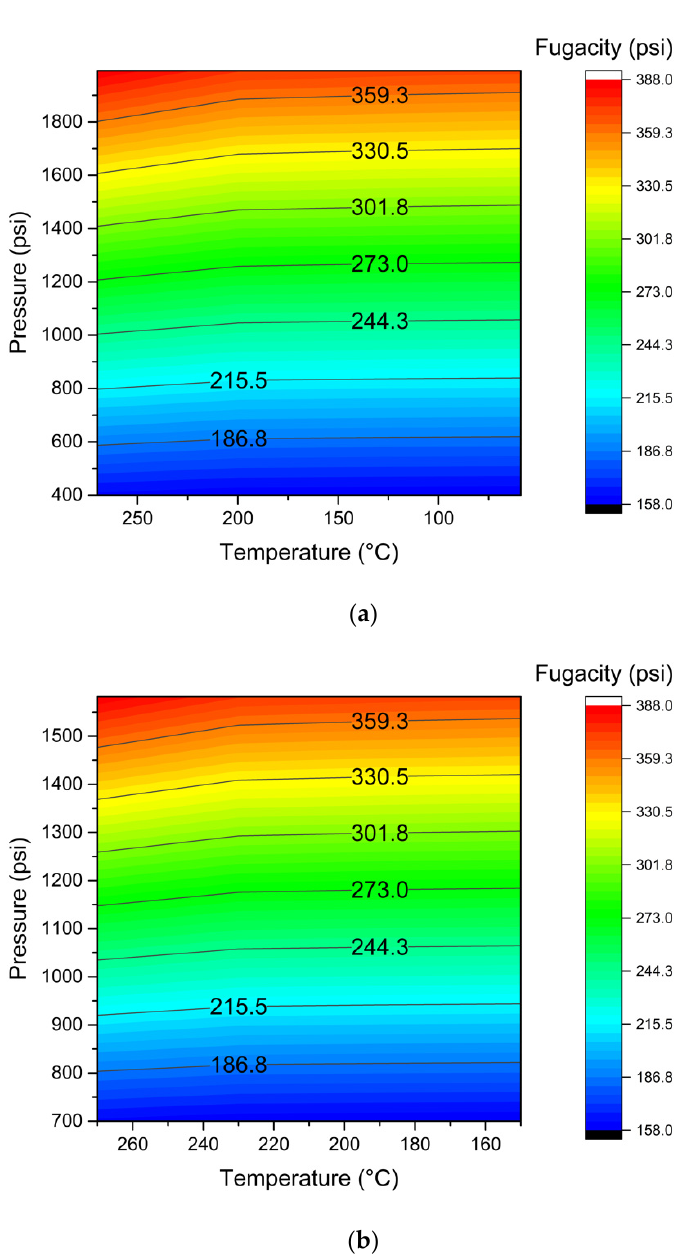
Figure 7. Fugacity contour of H 2 generated during the steam injection in ( a ) absence and ( b ) presence of nanoparticles on HO2 between reservoir pressure (400 psi) and overburden pressure (1990 psi) as a function of temperature decline.